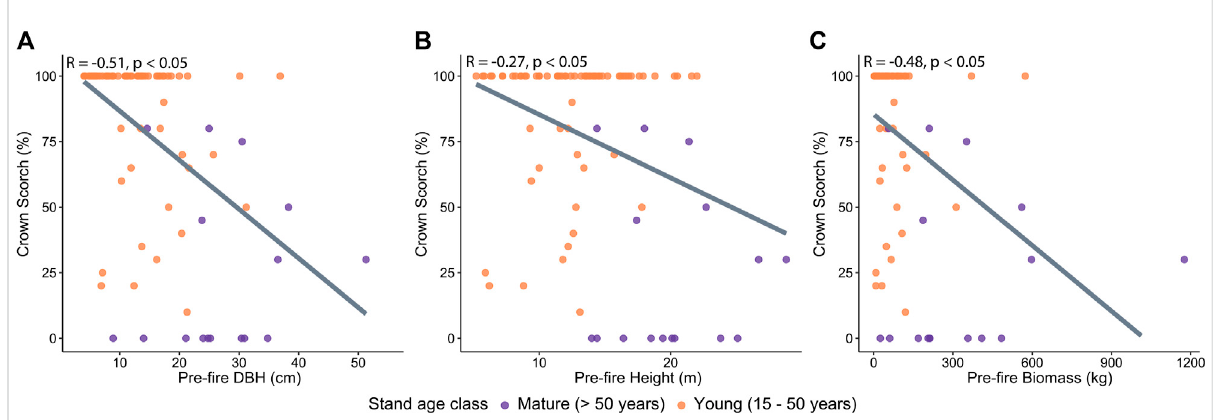
FIGURE 7 Thescatterplotsandtrendlinesbetweencrownscorch(%)andpre- fi re (A) DBH, (B) height,and (C)